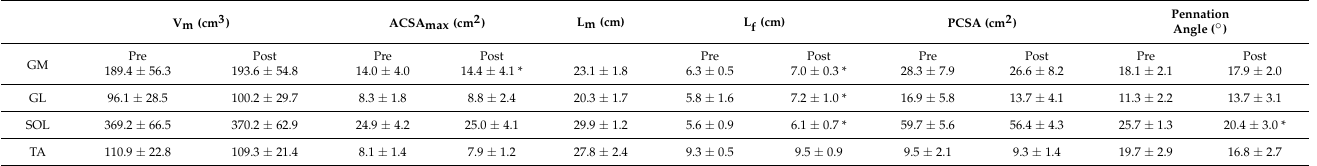
Table 1. Mean values ± SDs of the muscle architectural parameters of the GM, GL, SOL and TA muscles determined using the imaging techniques PD and DTI pre- and post-exercise. The length of the muscle was the same in the two conditions.